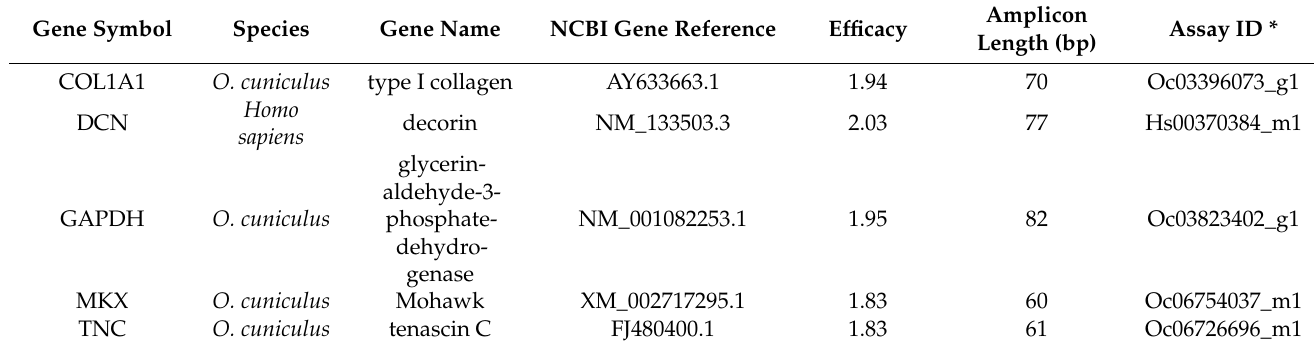
Table 2. Primers used to assess gene